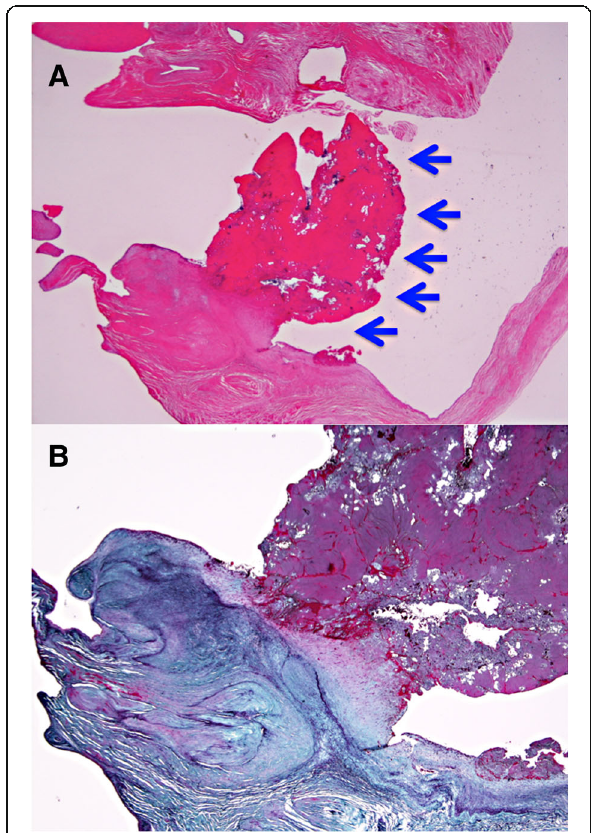
Fig. 2 Histological findings of vegetation in the mitral valve. No neutrophil infiltration or bacterial agglomeration is evident. Arrows indicate vegetation (hematoxylin and eosin stain, magnification × 10) ( a ). No valve tissue damage was seen (Elastica Masson stain, magnification × 20) ( b